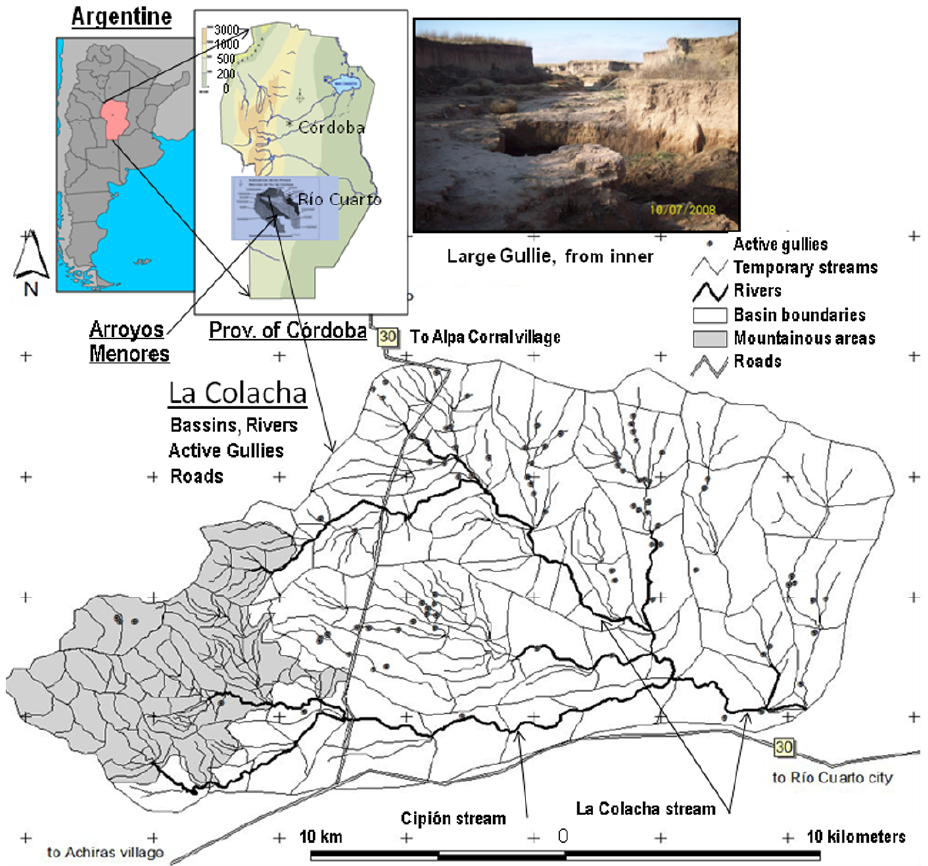
Fig. 1. Location of study area “La Colacha” in Argentine Republic. The altitude map is from “Mapas Visiting”, much reduced. Includes a view of basins, rivers, active gullies, roads. A north/south chain of old mountains lies west of study